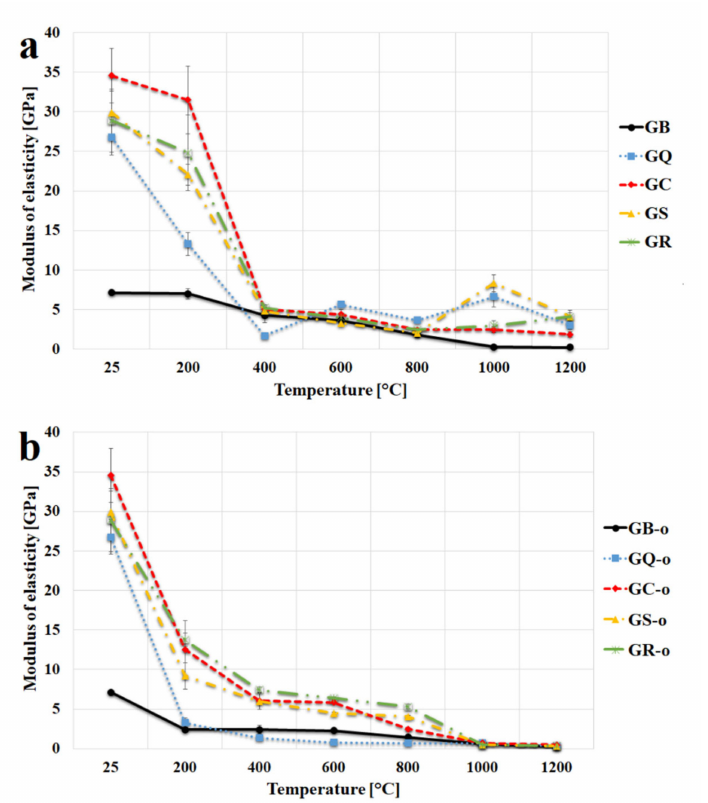
Figure 8. Modulus of elasticity of the geopolymer binder and geopolymer composites at a room temperature after exposure up to 1200 ◦ C ( a ) and in situ at temperatures from 25 ◦ C to 1200 ◦ C ( b